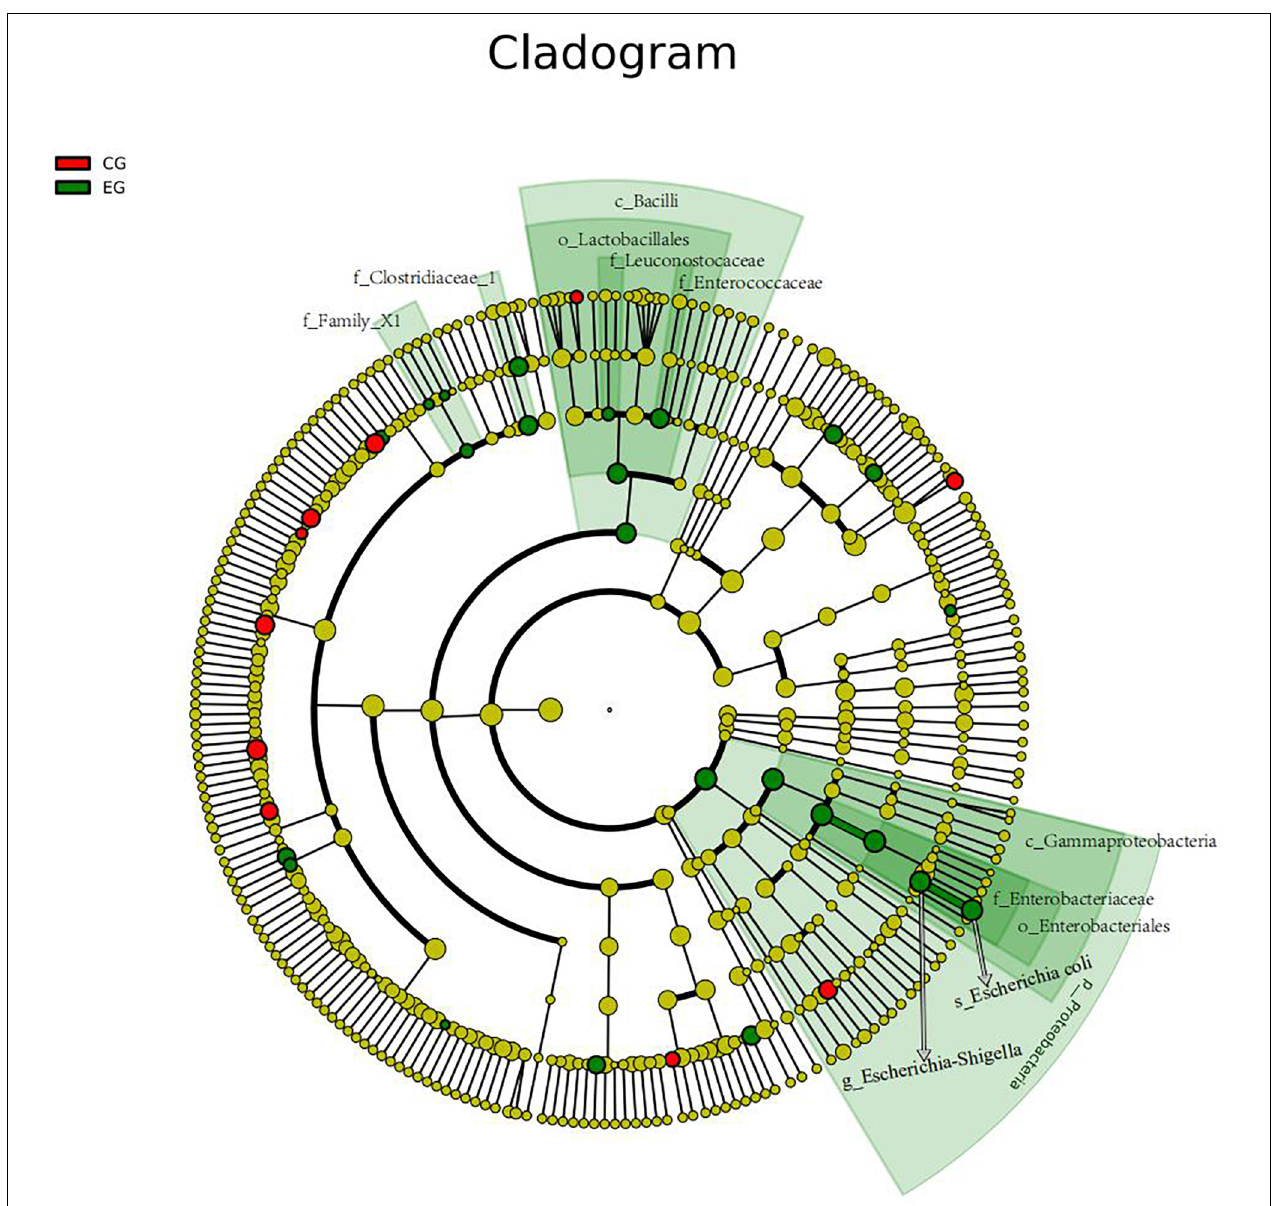
FIGURE 3 | The gut microbiota of the untreated DLBCL patients showed a continuous evolutionary relationship at six levels: Proteobacteria (phylum), Gammaproteobacteria (class), Enterobacteriales (order), Enterobacteriaceae (family), Escherichia-Shigella (genus), and E. coli (species). The circles radiating from the inside to the outside represent the taxonomic level from phylum to species. Each small circle in different classification level represents a classification at this level, and the diameter of small circle is directly proportional to the relative abundance. The species with no significant difference were uniformly colored yellow. The red nodes indicated the microbial groups that played an important role in the CG, and the green nodes showed the microbial groups that played an important role in the